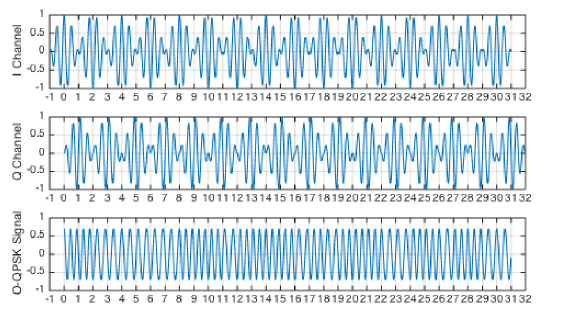
Fig. 2. DSSS O-QPSK Modulated